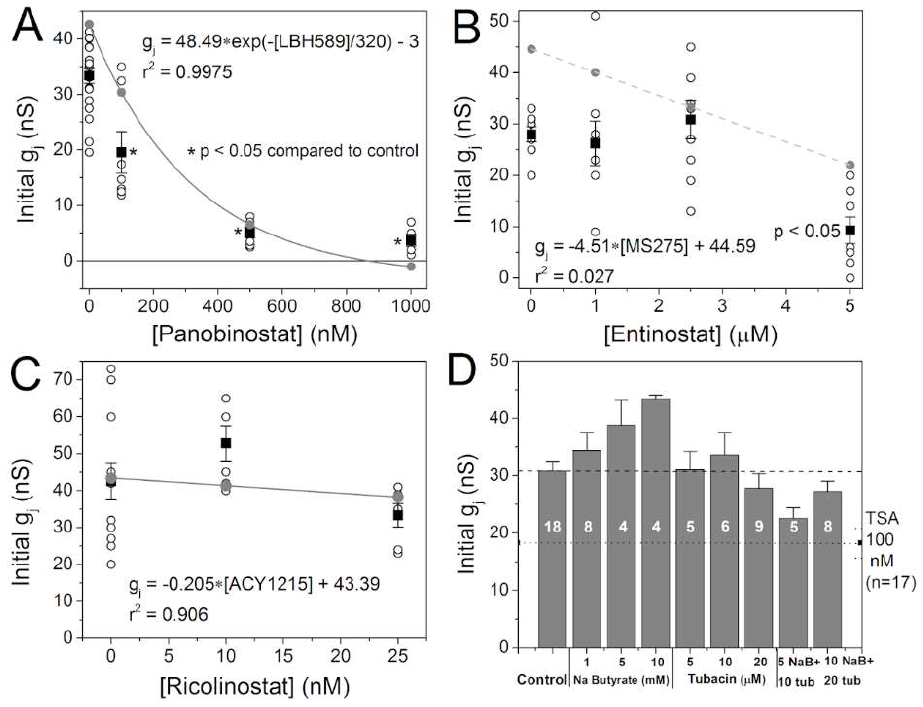
Figure 2. Effects of pan- and class-selective HDAC inhibition on gap junction coupling. ( A ) The gap junction conductance (g j ) was measured between neonatal mouse ventricular cardiomyocytes (NMVMs) treated with 0, 100, 500, or 1000 nM panobinostat for 18–24 h in culture. Pan-HDAC inhibition reduced g j in a concentration-dependent manner. ( B ) Class I HDAC selective inhibition with entinostat had no effect on ventricular g j except at the highest, and least selective, concentration tested. ( C ) Ricolinostat, a class IIb HDAC6-selective inhibitor produced a slight, but non-significant, increase and then decrease in ventricular g j as the concentration was increased from 10 to 25 nM. ( D ) The effect of a weak HDAC class I/IIb inhibitor, sodium butyrate (NaB), and the prototype HDAC6 inhibitor, tubacin, on g j were tested independently and in combination [21–23]. NaB non-significantly increased g j in a concentration-dependent manner while tubacin (tub) produced a non-significant increase and then decrease in g j with increasing concentration. When concentrations of NaB and tubacin that increased g j by 26% and 9% respectively were applied in combination, g j decreased by 26%, indicating an opposite and negative response when class I and IIb HDAC inhibition is combined.